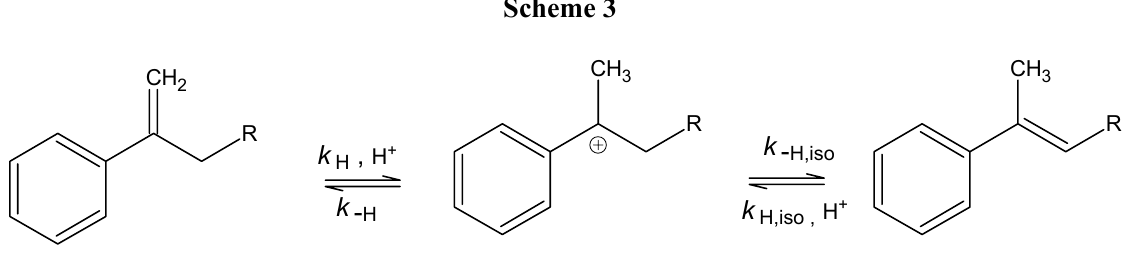
Table IV Rate constants and standard deviations of rate constants k